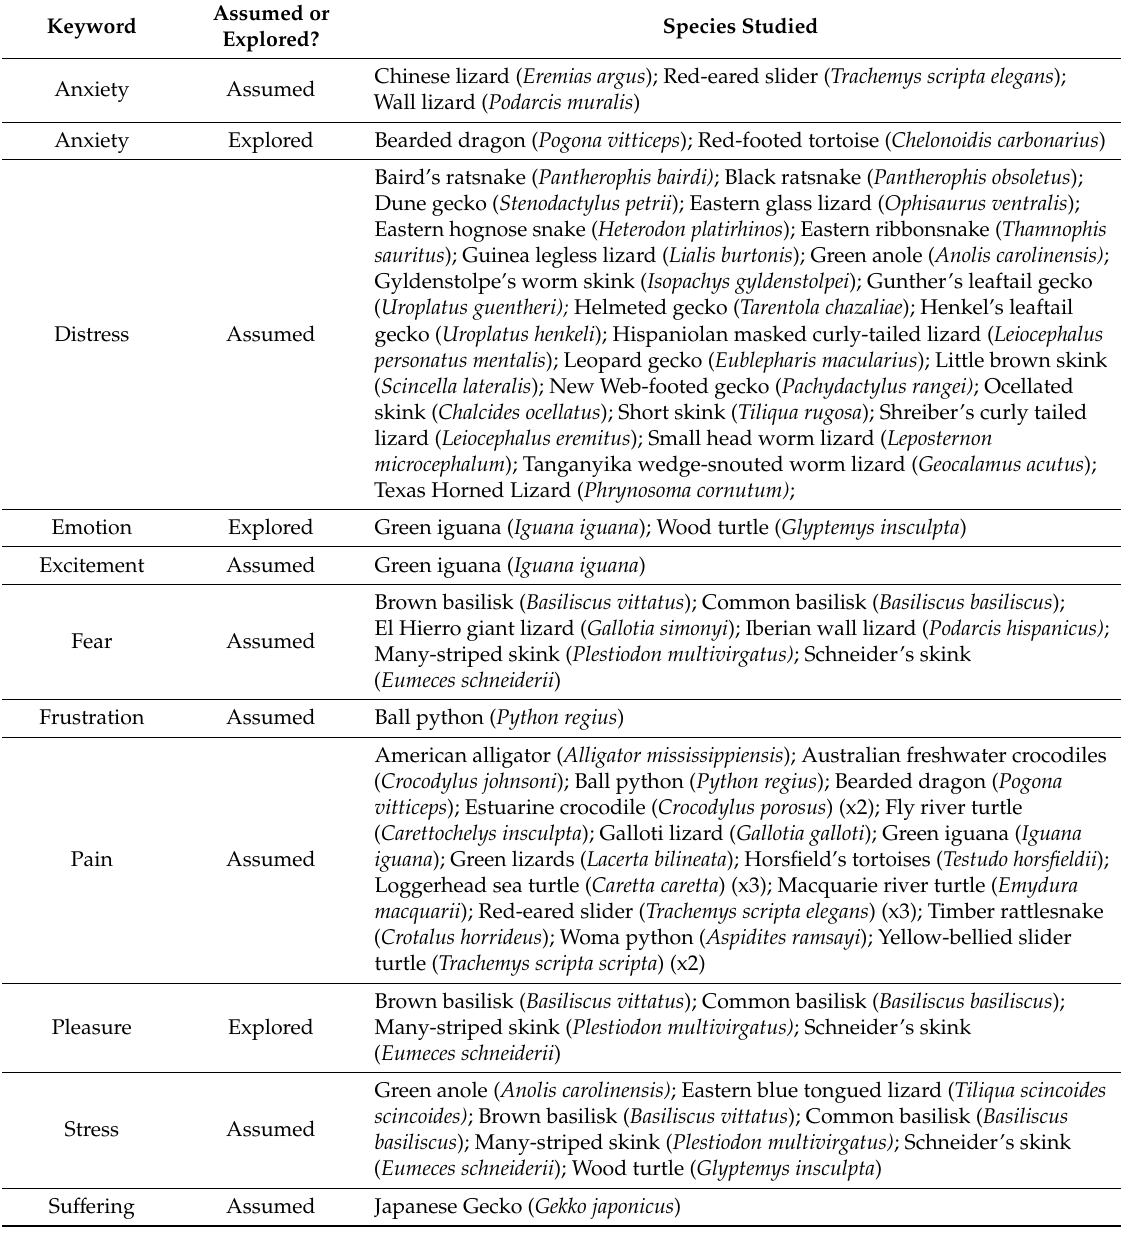
Table 3. The species studied in each of the returned articles. Species featured in more than one article for the keyword are